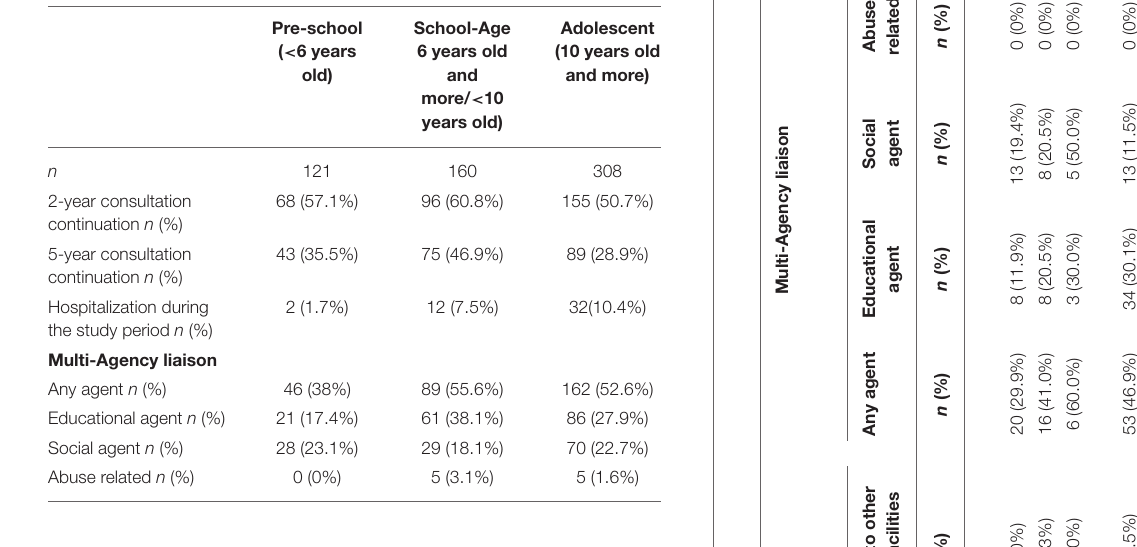
TABLE 2 | Clinical features of participants in each